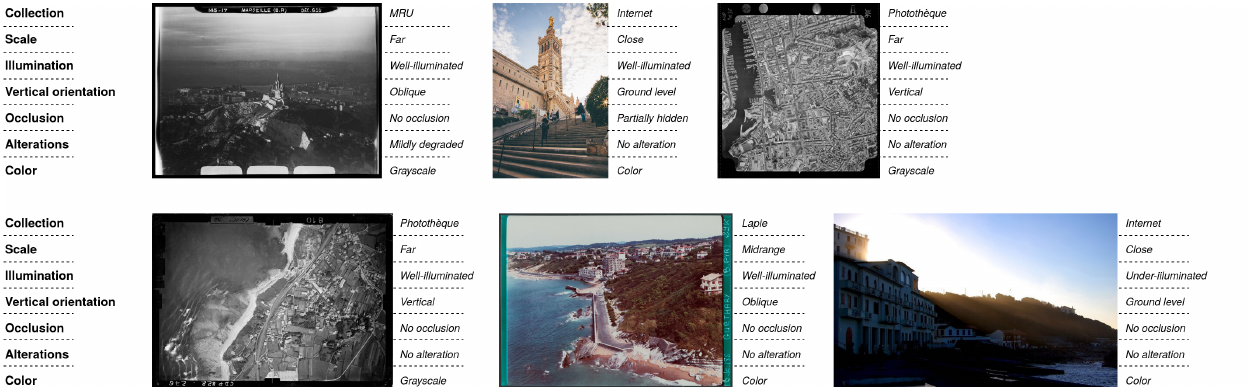
Figure 2. Examples from the ALEGORIA dataset, images in the same row belong to the same class (first row: “Notre-Dame de la Garde”, second row: “Guethary”). Attribute values are indicated on the right side of images in italics , with attribute names in the legend at the beginning of each